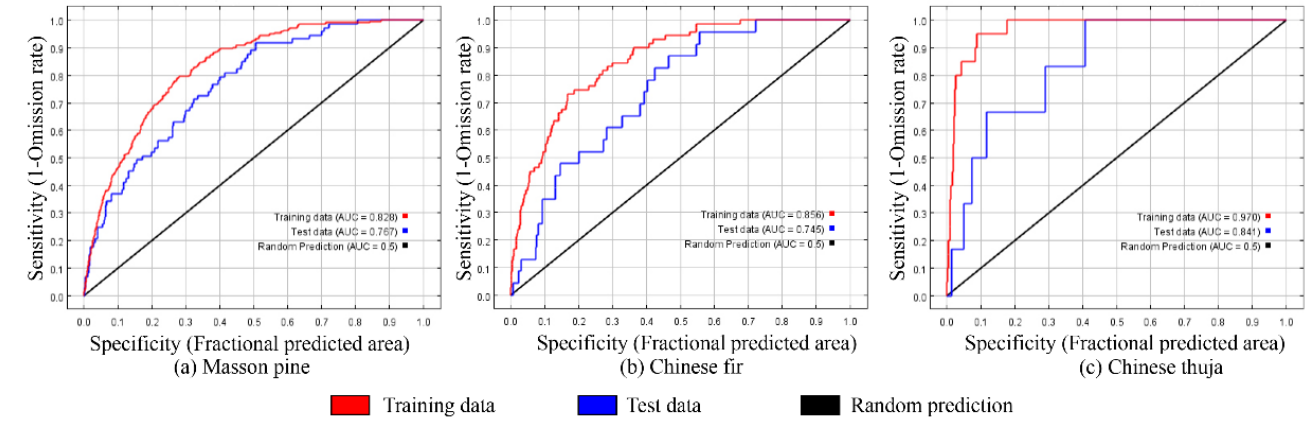
Figure 4. The ROC curve. Figure 4. The ROC Table 4. Evaluation table of simulation accuracy of main coniferous species in Hubei Province.